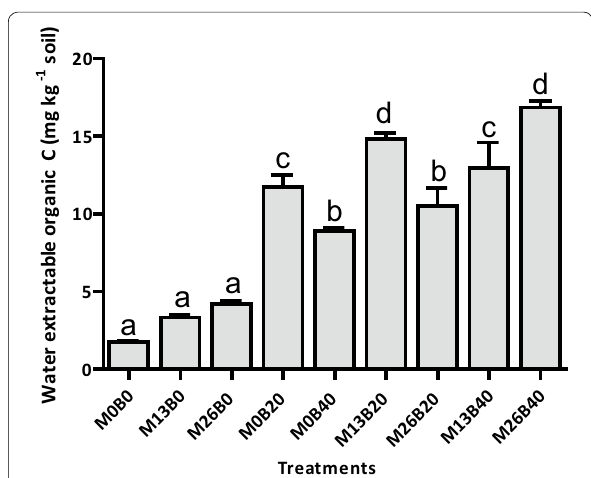
Fig. 3 Effect of treatment on WEOC during the incubation of sandy soils amended with cow manure (M), biochar (B) and B–M mixtures over 56 days. Same letter(s) above the bars indicate no significant difference between treatments at p 0.05. Vertical bars represent = standard error of the mean (n 3). M0, M13 and M26 are M rates at 0, = 13 and 26 tons ha − 1 respectively. B0, B20 and B40 are B rates at 0, 20 and 40 tons ha − 1 , respectively